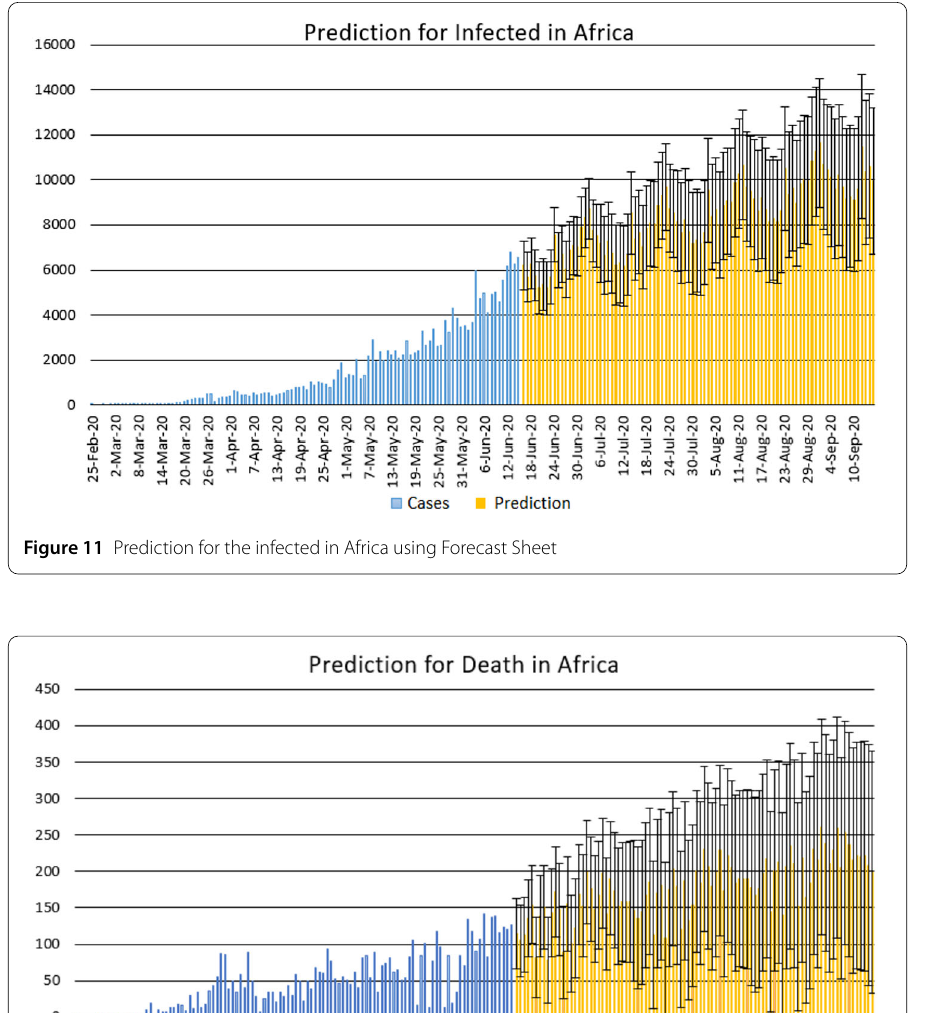
6 An analysis of COVID-19 spread based on fractal interpolation and fractal